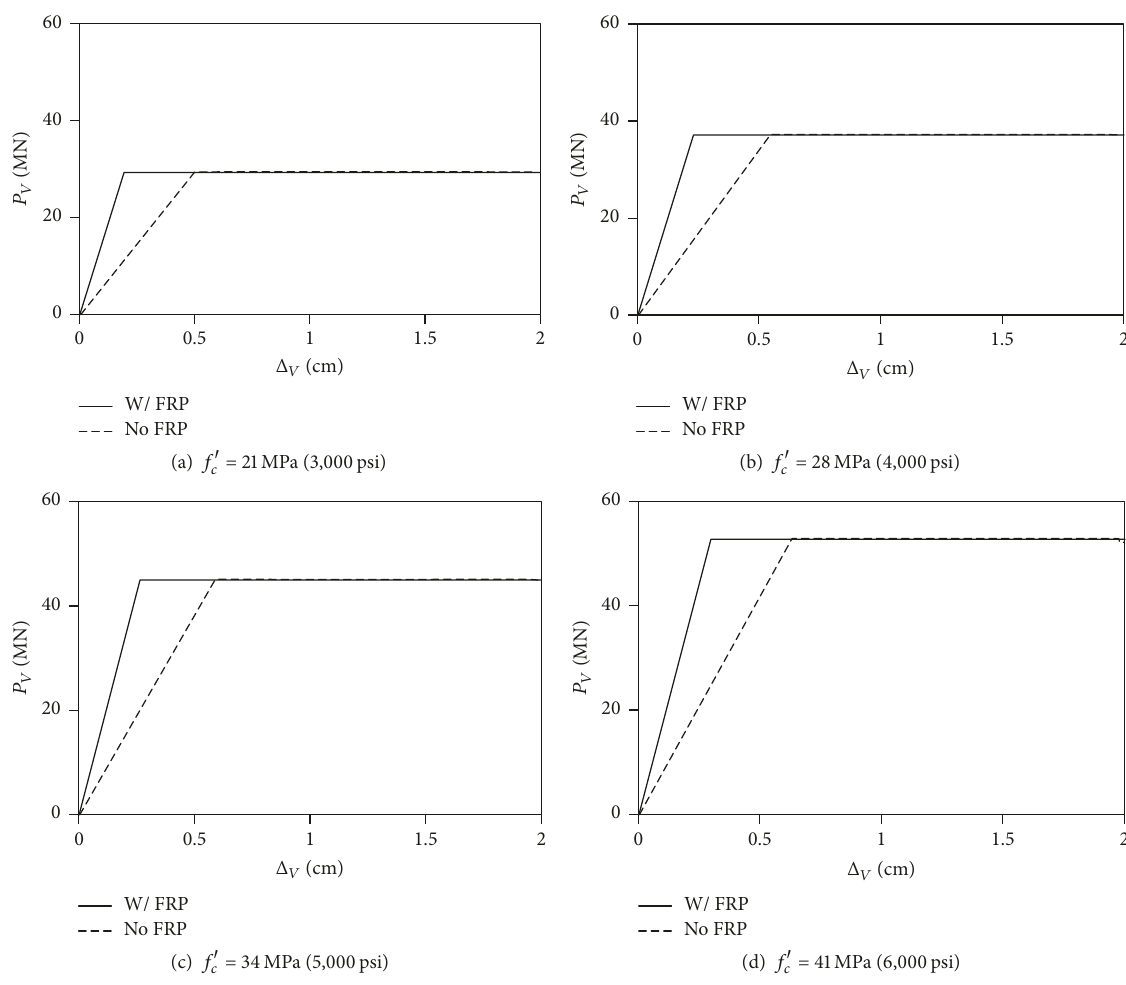
Figure 4: Pier section (0.9m by 0.9 m) subjected to vertical loads (thickness of FRP wrap = 3.3